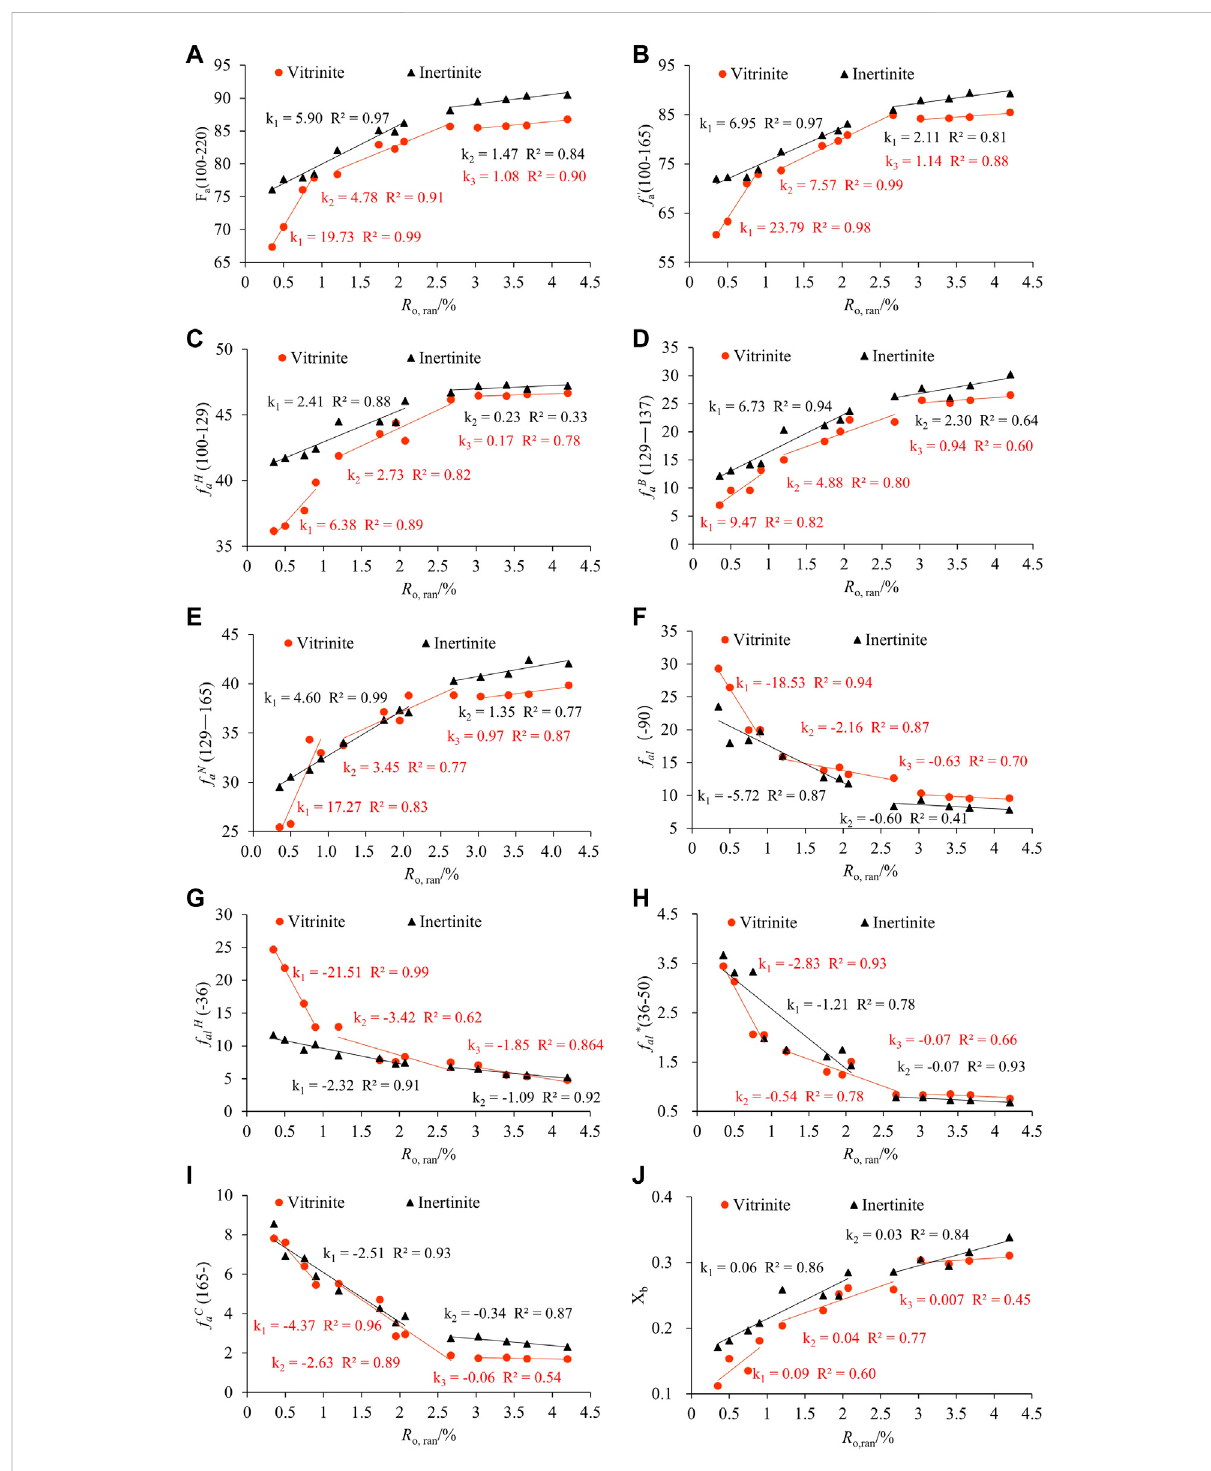
FIGURE 8 Relationships between R o ,ran and 13 C NMR structure